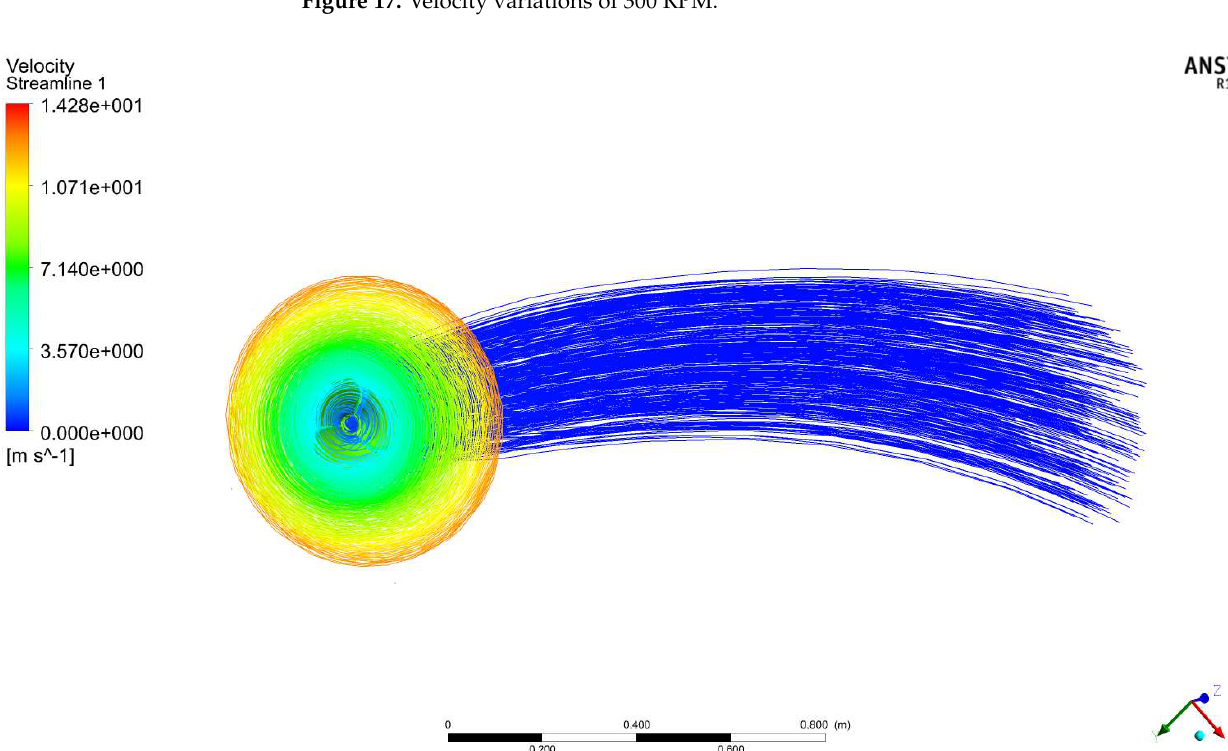
Figure 19. Velocity variations of 500 RPM.